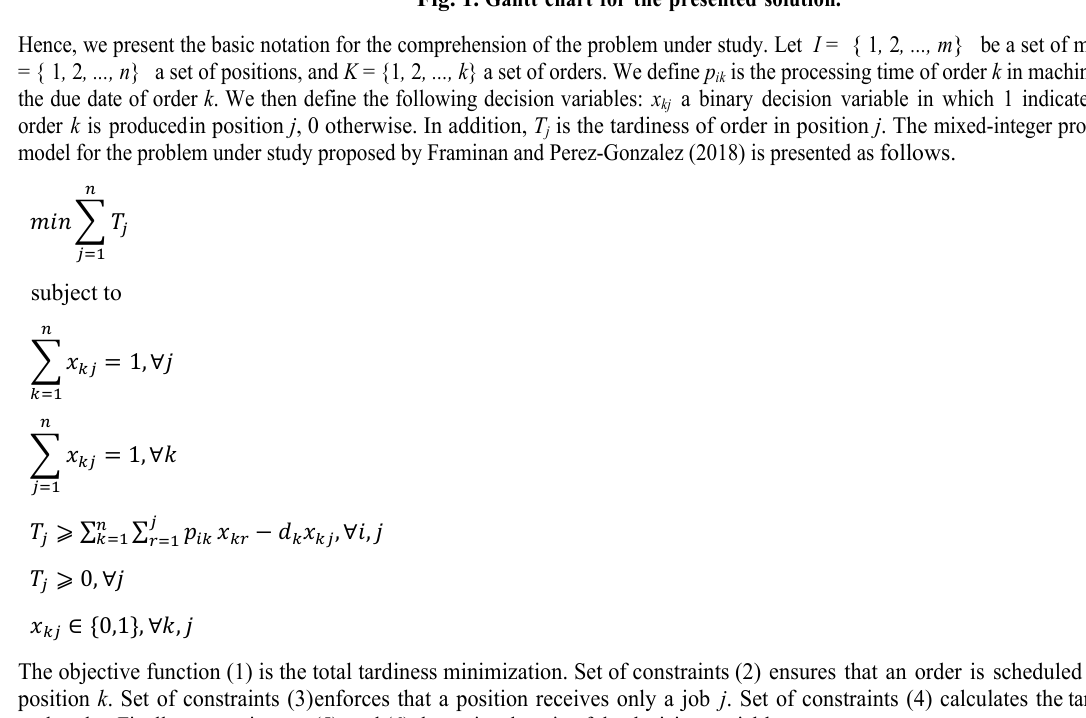
Fig. 1. Gantt chart for the presented